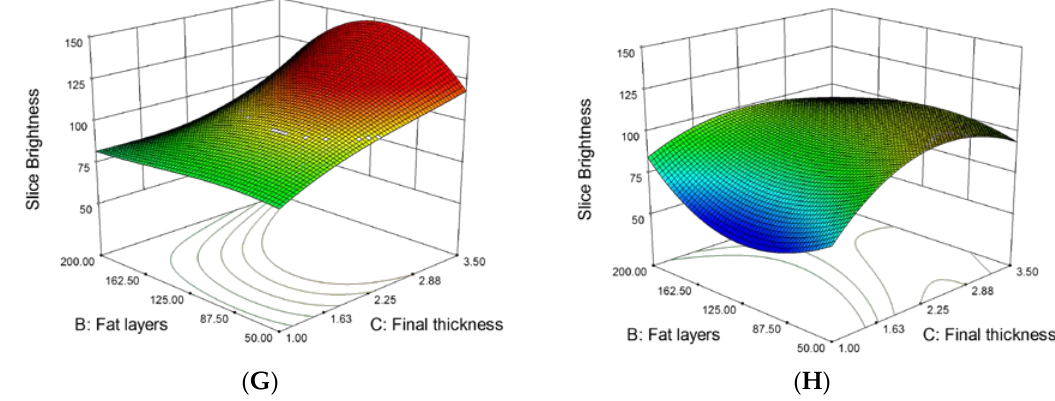
Figure 1. Response surface plots: Effect of final dough thickness and number of fat layers on firmness (Extended Craft Knife) ( A , B ), firmness (Multiple Puncture Probe) ( C , D ), number of cells ( E , F ) and slice brightness ( G , H ) of puff pastry at levels of 0% and 40% fat reduction.